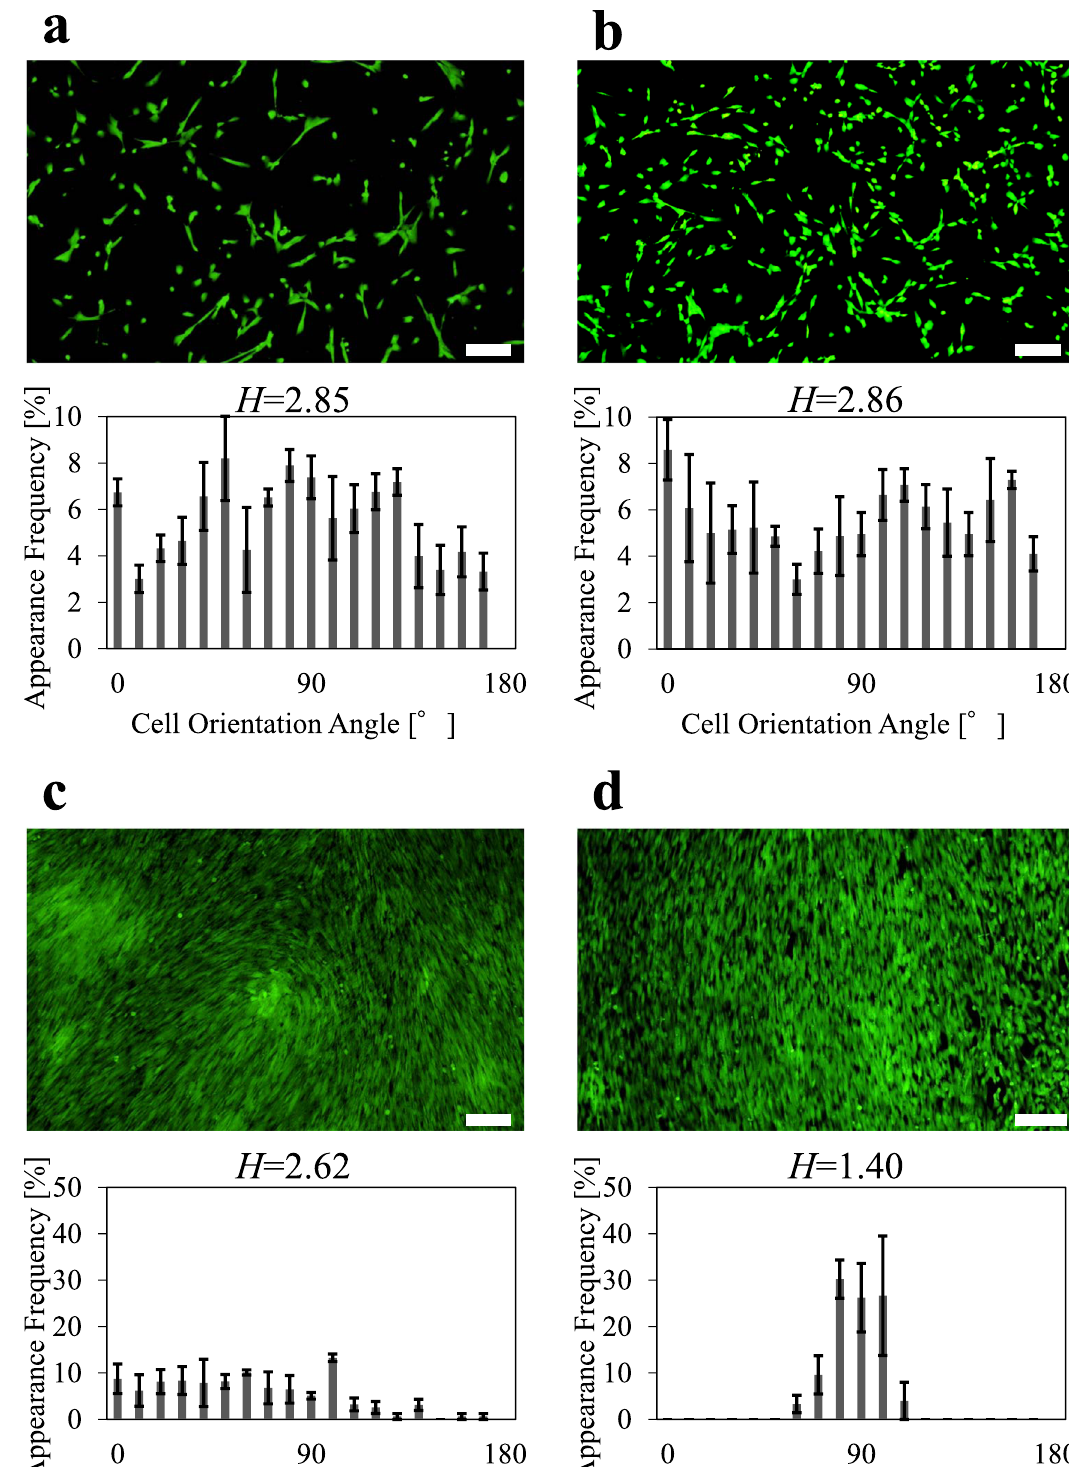
Fig. 1 Orientation of cells. Image and quantitative analysis of indivi- dual cells for NS ( a ), individual cells for CS ( b ), cells in a cell sheet for NS ( c ), and cells in a cell sheet for CS ( d ). NS no strain, CS cyclic